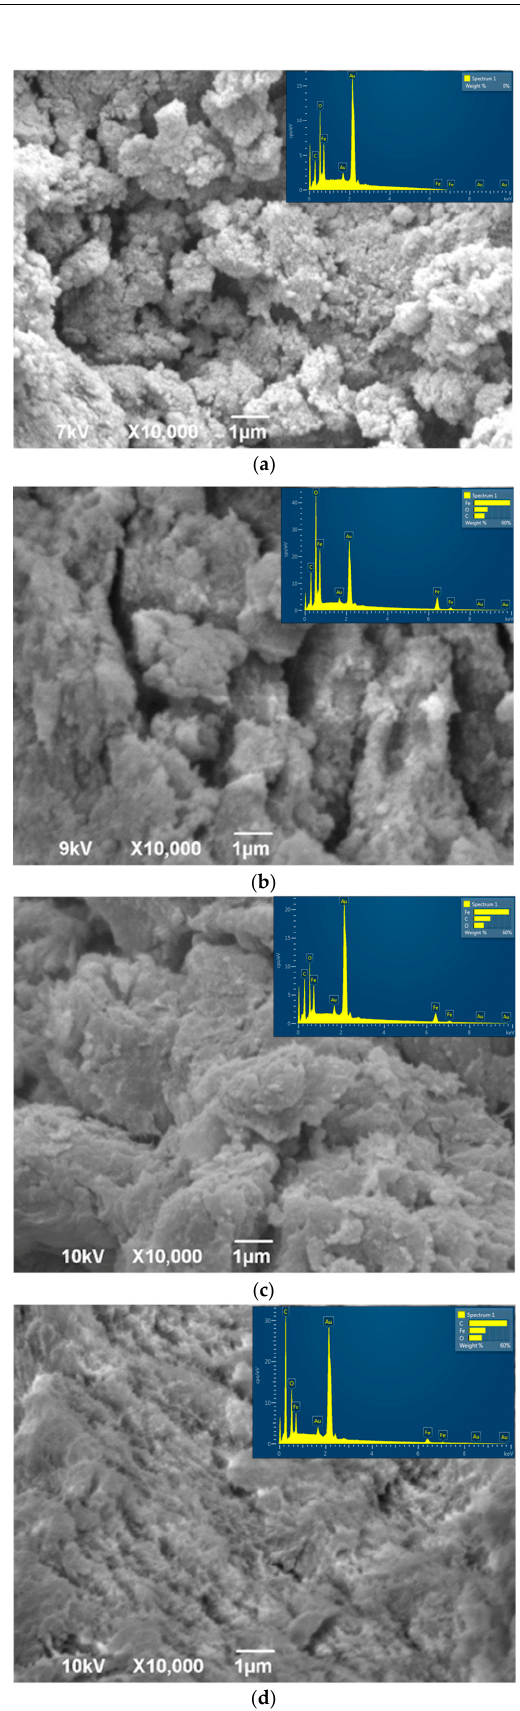
Figure 4. SEM micrographs and EDS of the samples Fe 3 O 4 /NC with different content of NC: ( a ) Fe 3 O 4 /NC1, ( b ) Fe 3 O 4 /NC2, ( c ) Fe 3 O 4 /NC4 and ( d ) Fe 3 O 4 /NC8. An energy dispersive X-ray analysis (EDS) was performed at the all Fe 3 O 4 /NC com- posite samples. The results confirmed the presence of Fe, C and O in the elemental com- positions.